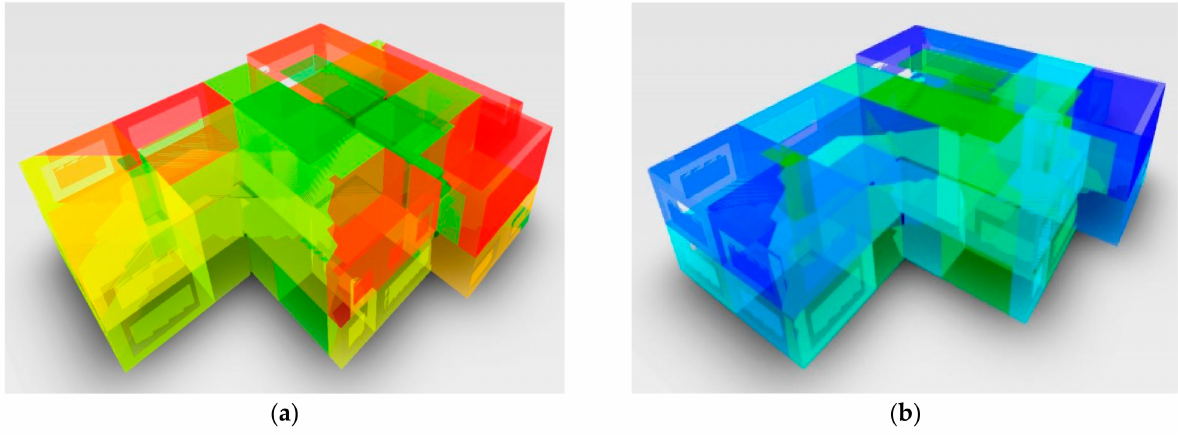
Figure 6. Insight energy analysis for office building. ( a ) Cooling load analysis; ( b ) Heating load analysis.